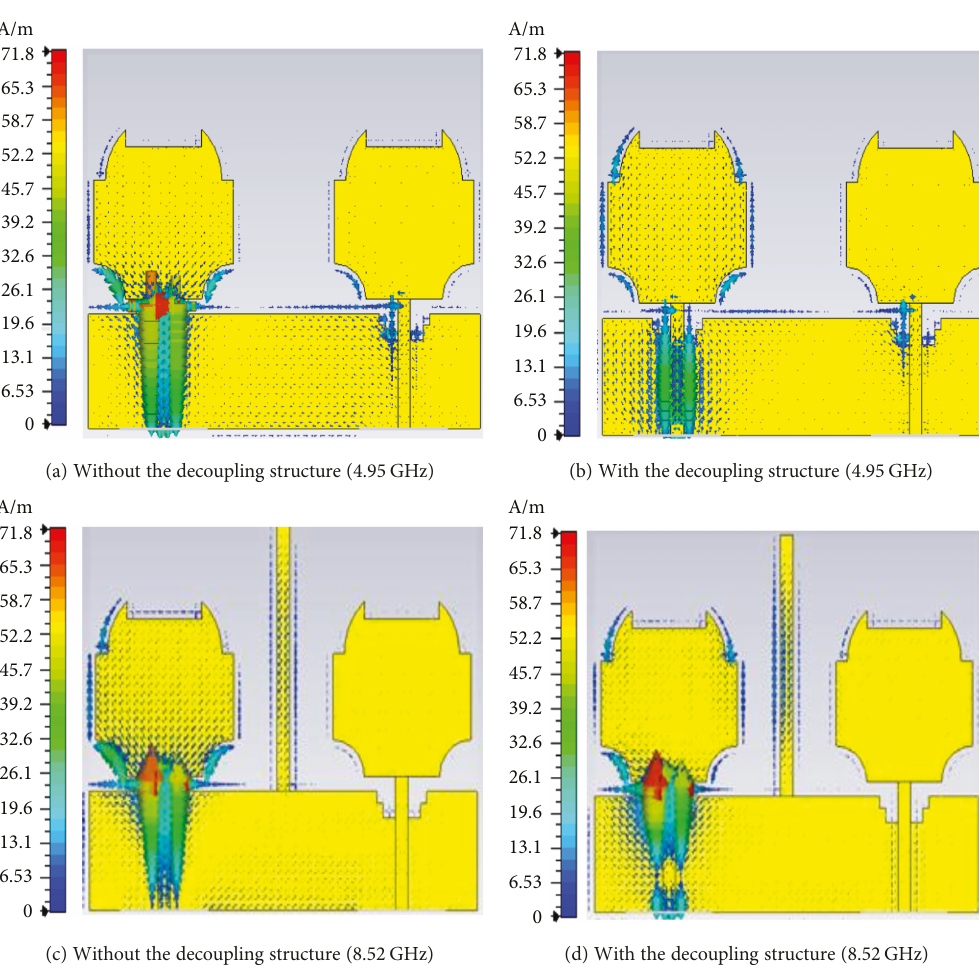
Figure 8: Current distribution of the proposed